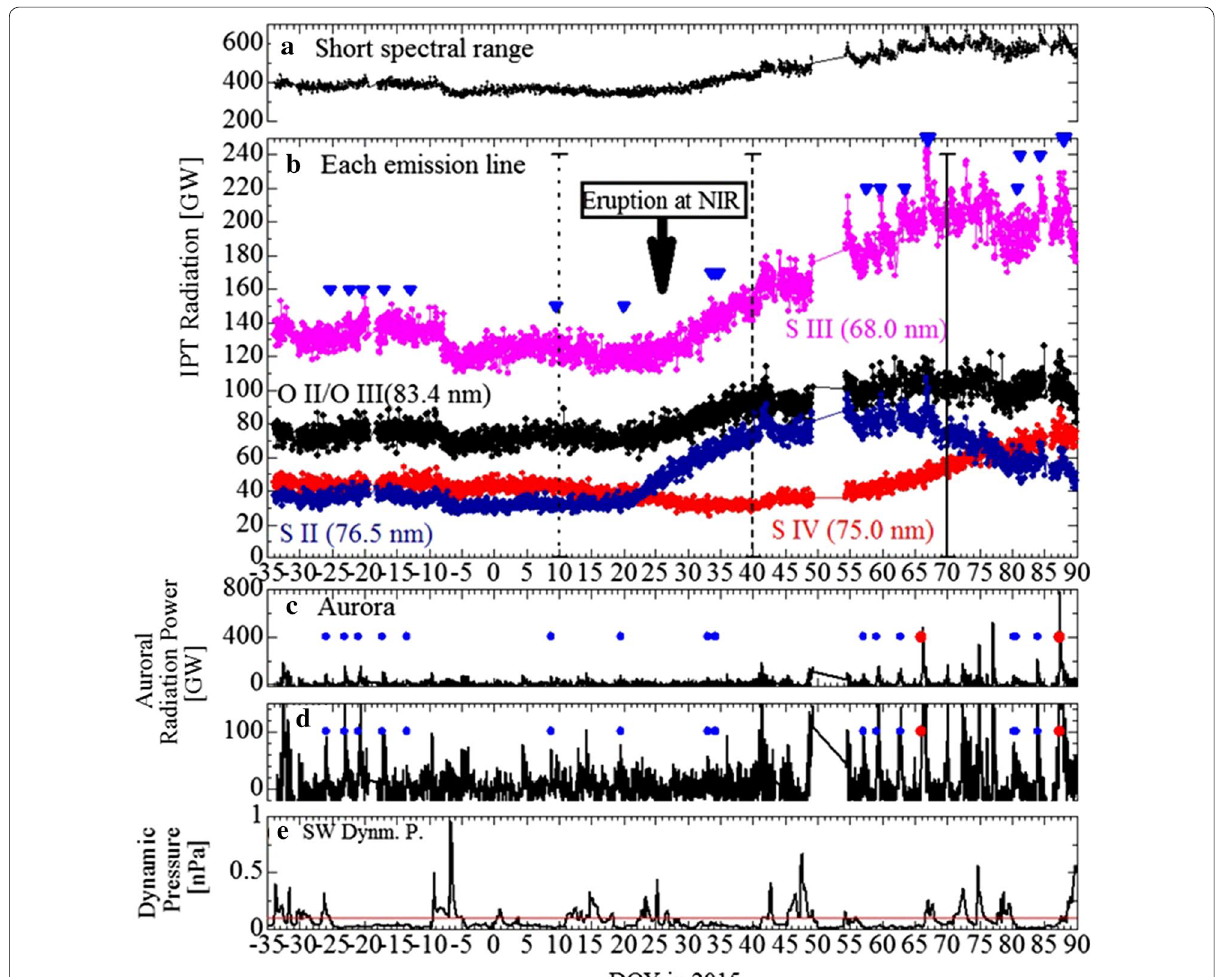
Fig. 3 a Long-term variation of the radiation power of the IPT in the shorter spectral range (65–78 nm) versus day-of-year (DOY) in 2015. The brightness on dawn and dusk sides was averaged. b Time series of each emission brightness from singly (S II), doubly (S III), and triply (S IV) ionized sulfurs and oxygen ions (OII/OIII). The timing of the rise seen for singly ionized sulfur is the earliest, 5 days earlier than the volcanic eruption identi- fied from ground-based observations in the infrared region (de Kleer and de Pater 2016b). The triangles mark the times of the brightenings corre- lated with the internally driven aurorae. After DOY 40, the brightenings are clear in this plot. c Aurora light curve with spectral binning (90–147 nm) applied. The circles indicate the times when the internally driven transient events of aurorae started. After DOY 40, transient events occurred more frequently and became brighter. d The same as ( c ) but with an enlarged scale to clearly show small transient events before DOY 40. e Simulated dynamic solar wind (SW) pressure. We extrapolated SW data measured on Earth to Jupiter with a simulation of the magnetohydrodynamic (MHD) propagation. The SW with high dynamic pressure is expected to arrive at Jupiter (e.g., DOY 10, 11, 47, 66 and 74). The red line indicates our criteria for defining quiet SW conditions for Jupiter. Note that the marks in ( b )–( d ) point to the period with a dynamic SW pressure below 0.1